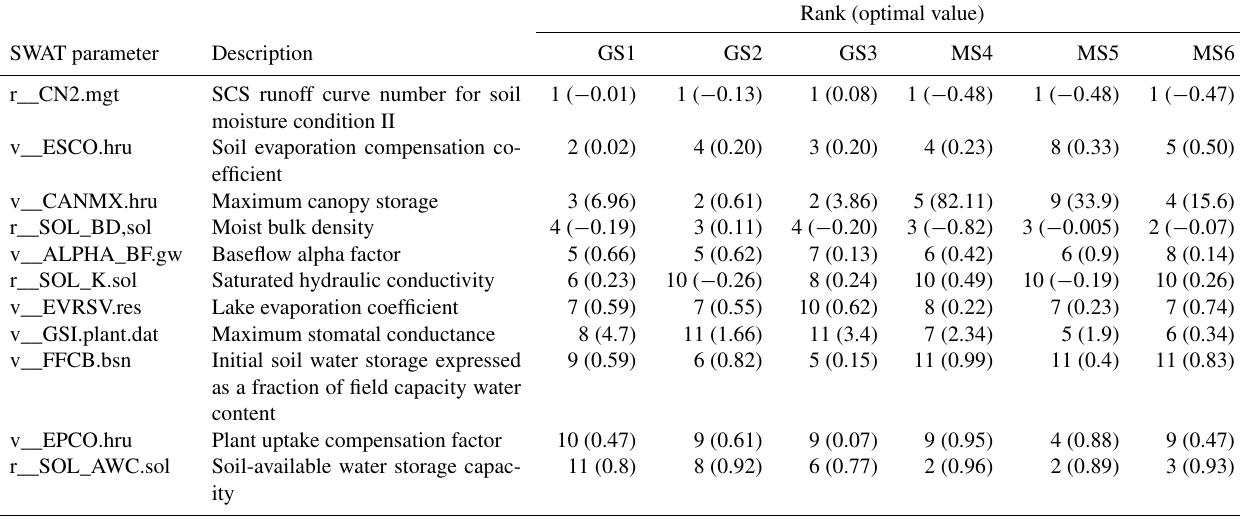
Table 2. Sensitivity rank and calibrated parameters with their optimal value for the three SWAT model runs through the six calibrations. Rank (optimal value) SWAT parameter Description GS1 GS2 GS3 MS4 MS5 MS6 r__CN2.mgt SCS runoff curve number for soil 1 ( − 0 . moisture condition II